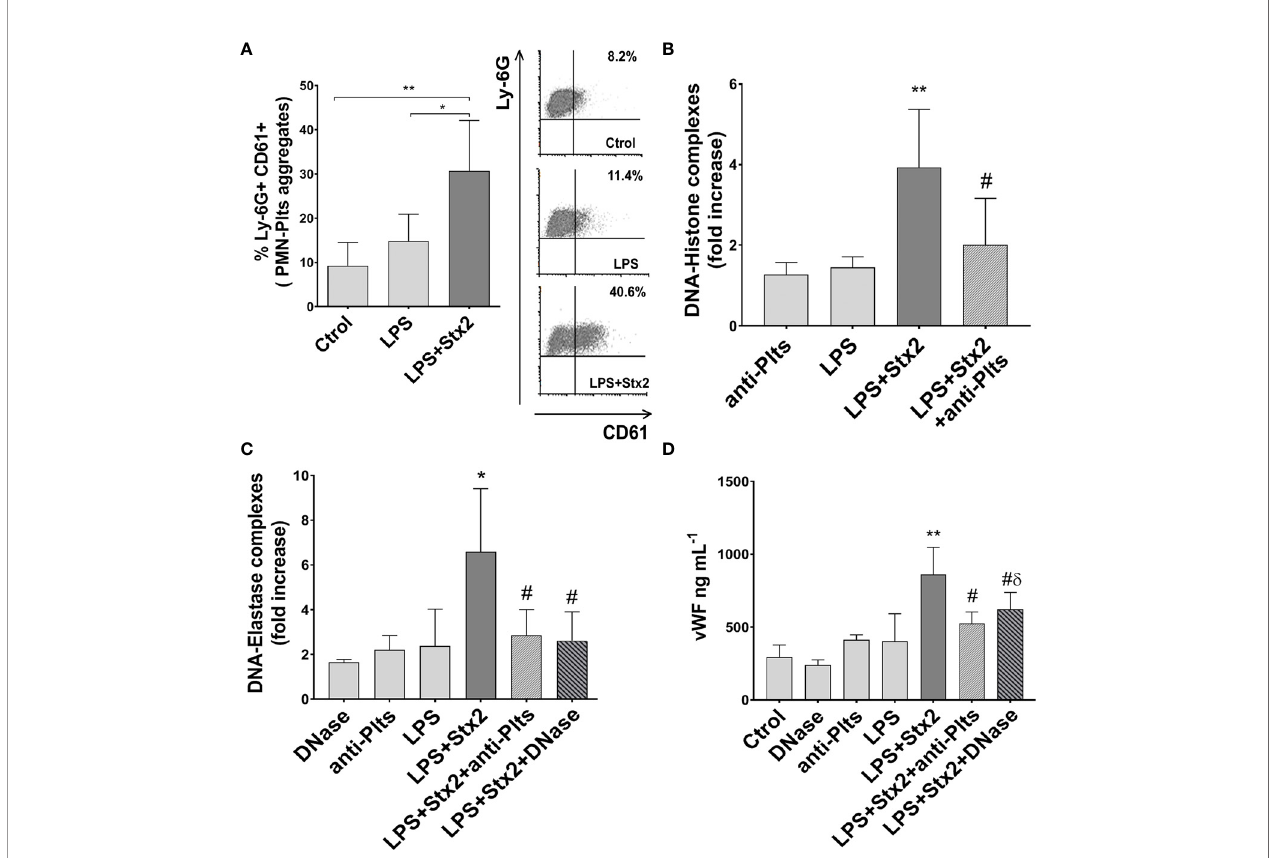
FIGURE 6 | Mixed aggregates PMN – Plts, netosis, and endothelial dysfunction in LPS+Stx2-treated mice. Mice were treated with PBS (Ctrol), LPS (i.p.) alone or also with Stx2 (i.v.) 1 h after LPS. At 72 h, mice were anesthetized for bleeding before sacri fi ced. (A) Percentage of Ly-6G+ CD61+ mixed PMN – Plts aggregates measured in whole blood by fl ow cytometry. Representative analysis of an independent experiment showing density plots is depicted on the right (Ctrol n = 4, Stx2 n = 6, LPS+Stx2 n = 6). *p < 0.05; **p < 0.01. (B) NETs were detected in the plasma of treated mice using a DNA – Histone ELISA kit. For Plts depletion, mice received daily doses of a rabbit anti-mouse Plts immune serum. Results were expressed as the fold increase absorbance relative to PBS injected mice (anti-Plts n = 6, Stx2 n = 12, LPS+Stx2 n = 12, LPS +Stx2+anti-Plts n = 12). **p < 0.01 vs. anti-Plts and LPS; # p < 0.05 vs. LPS+Stx2. (C) For in vivo NETs digestion, mice received an i.v. injection of DNase every 12 (h) DNA – elastase complexes were determined in plasma by ELISA. Results were expressed as the fold increase absorbance relative to PBS injected mice (DNase n = 6, anti-Plts n = 6, Stx2 n = 12, LPS+Stx2 n = 12, LPS+Stx2+anti-Plts n = 12, LPS+Stx2+DNase n = 12). *p < 0.05 vs. DNase, anti-Plts, and LPS; # p<0.05vs.LPS+Stx2. (D) vWfplasmatic concentrations(ngml − 1 )weredeterminedinmicebyELISA(Ctroln=4,DNasen=6,anti-Pltsn=6,Stx2n=12,LPS+Stx2n=12,LPS+Stx2+anti-Pltsn=12,LPS+Stx2 +DNasen=12)(mean±SEM).**p<0.01vs.Ctrol,anti-Plts,DNase,andLPS; # p<0.05vs.LPS+Stx2; d